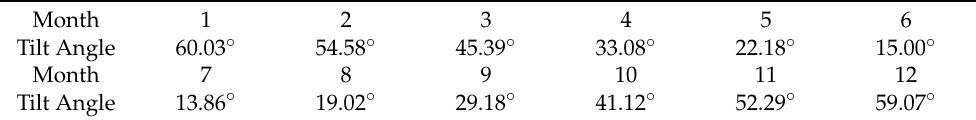
Table 1. The average value of the best inclination angle for each month in Weihai.